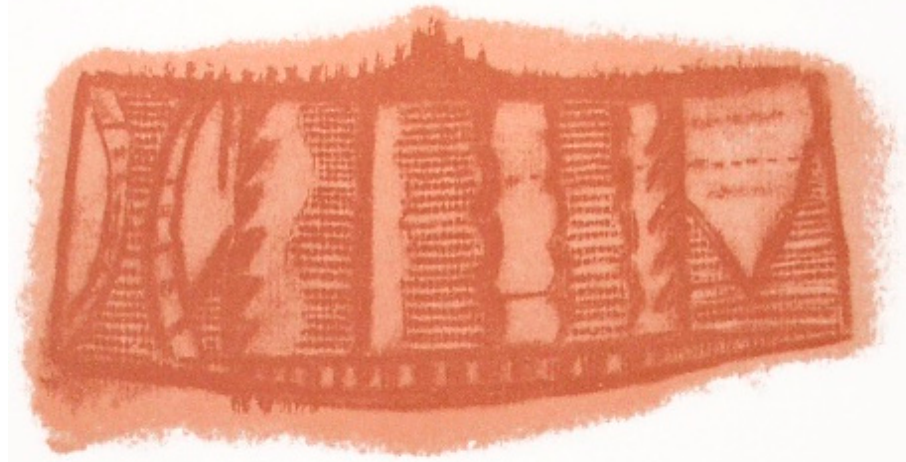
Figure 12. Interpretation of ideomorph by Alcalde Del Río, Breuil and Sierra [15].